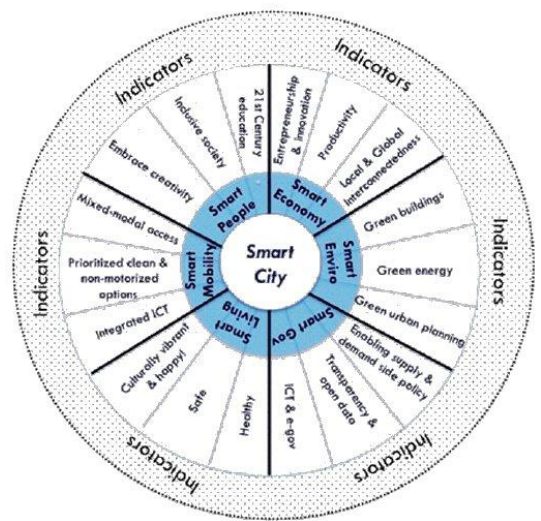
Figure 1. Smart city wheel. Reprinted with permission from ref. [41]. Copyright 2012 Boyd Cohen.